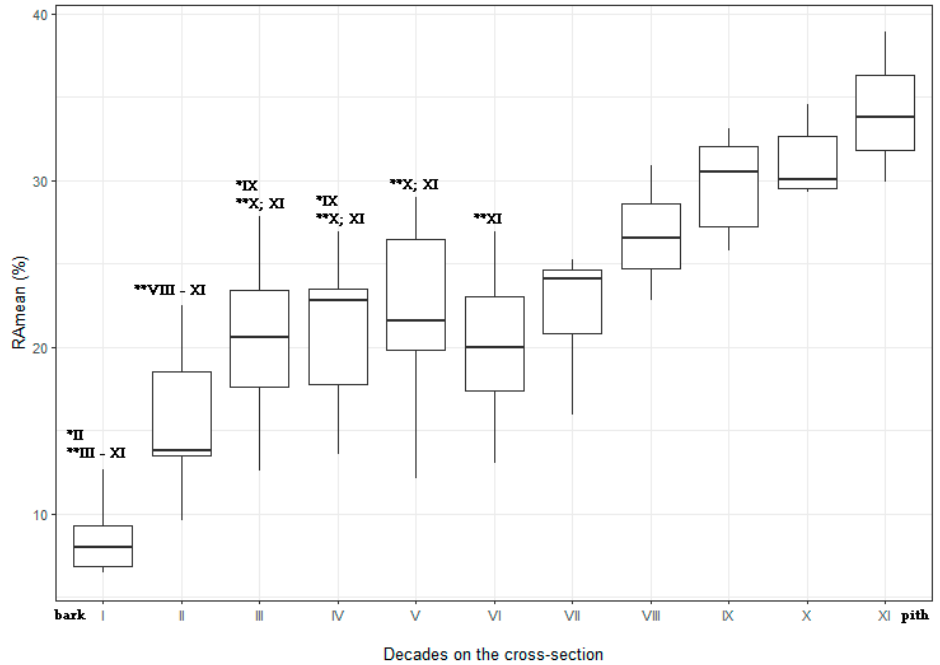
Figure 3. Distribution of mean Resi amplitude (%) on the cross-section of the trunk from bark (section I) to the pith (sections X/XI) with marked * significant and ** highly significant differences between wood samples using Tukey’s HSD test. Whiskers correspond to minimum and maximum values, boxes represent the 1st and 3rd quartile values, midlines indicate the median.